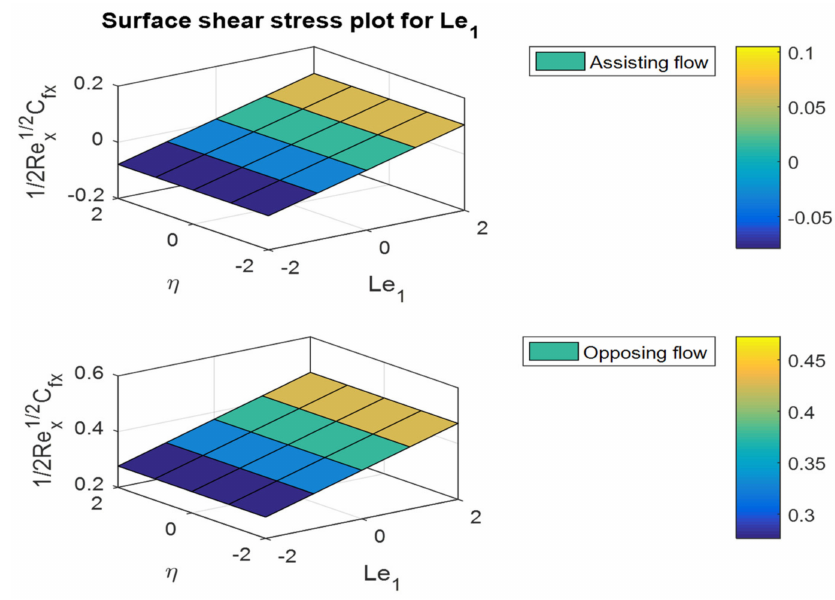
Figure 37. Surface plots for the f (cid:48)(cid:48) ( 0 ) for dissimilar values of Le 1